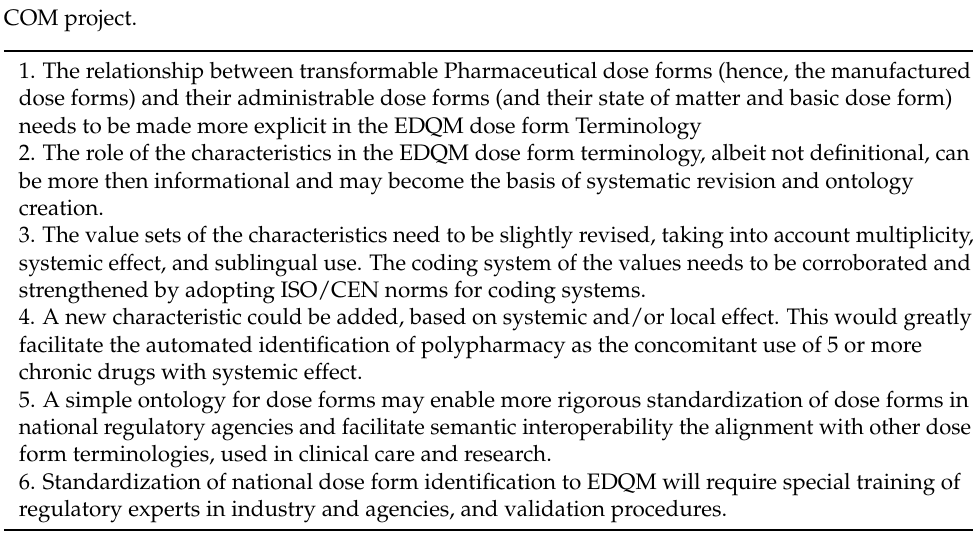
Table 3. Recommendations for EDQM dose form terminology as a global terminology within the implementation of global identification of medicinal products (IDMP), as proposed in the UNI- COM